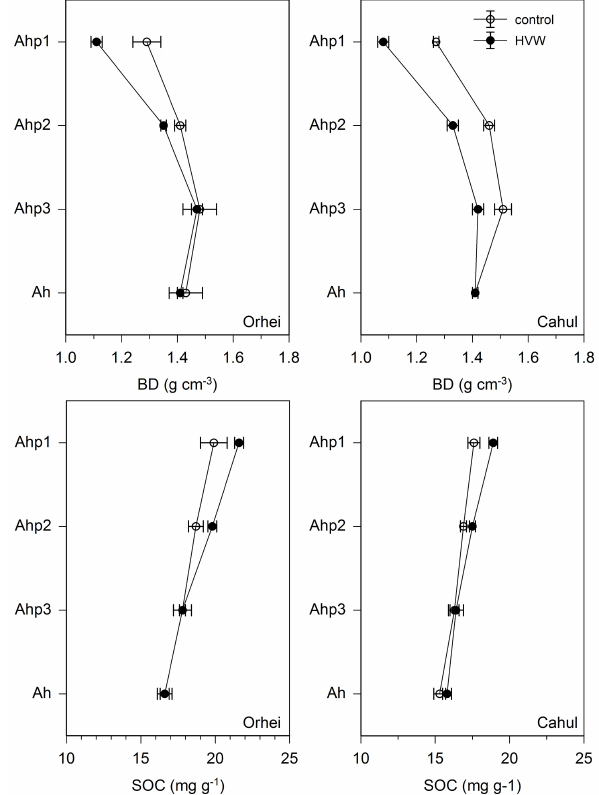
Figure 3. Bulk densities (BD) and soil organic carbon (SOC) con- tents of topsoil horizons of control and experimental sites in Orhei and Cahul after incorporation of HVW and harvest of the main crop. Error bars represent standard deviation ( n =